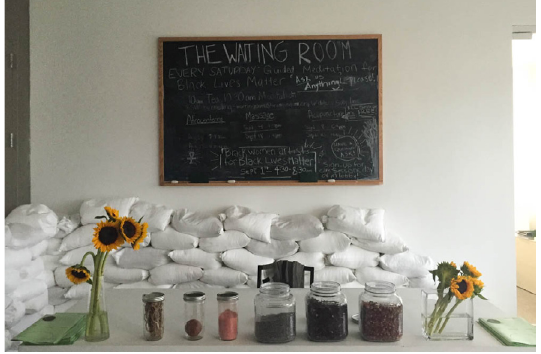
Figure 5 . Installation View, Simone Leigh: The Waiting Room , New Museum, 2016. Photo credit: Erin